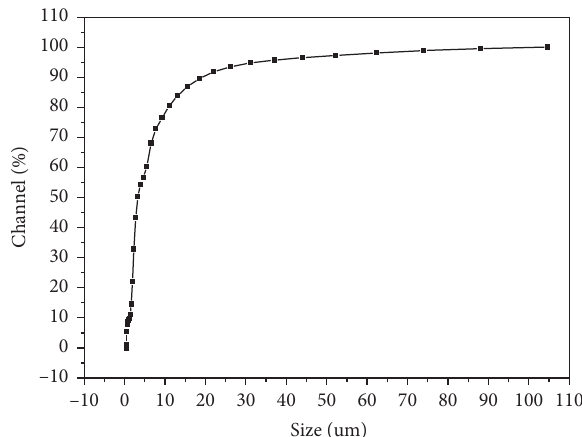
Figure 1: Particle size distribution of simulate rainwater.